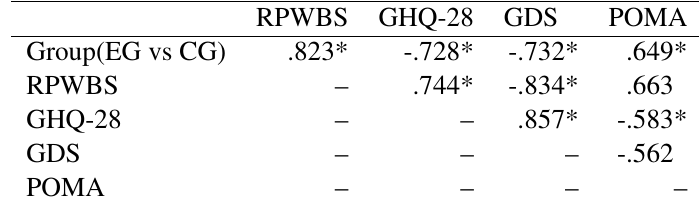
Table 3 Mean, standard deviations, and Pearson correlations (bilateral) of the study variables after the intervention (time 2)